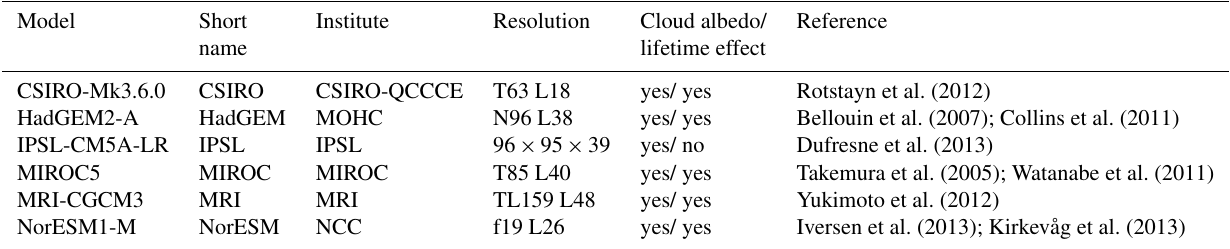
Table 1. Models considered in the study where the short names listed are used throughout. Model Short Institute Resolution Cloud albedo/ Reference name lifetime effect